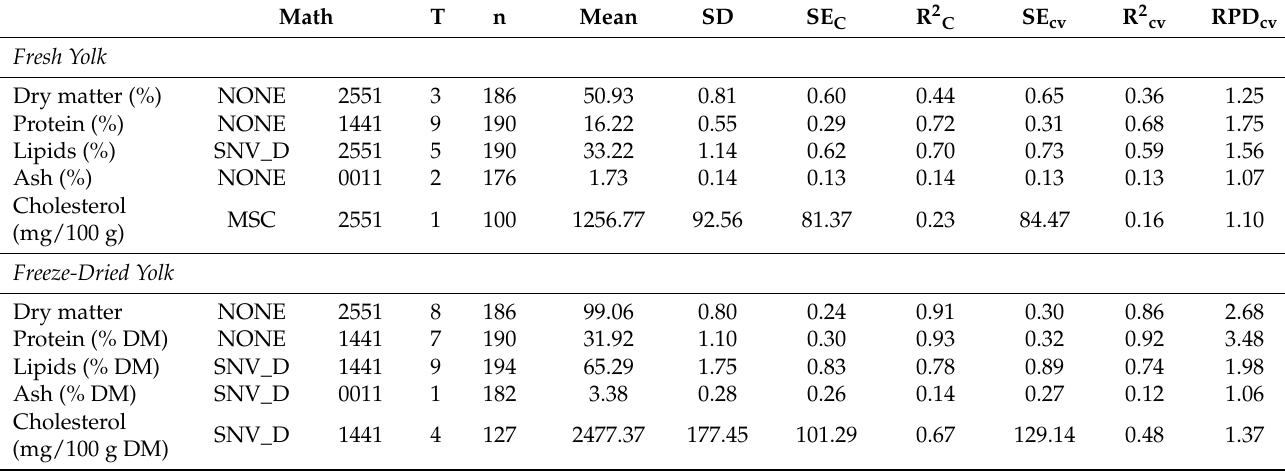
Table 4. Calibration and cross-validation statistics for modified partial least-squares regression models developed to predict the composition of fresh and freeze-dried